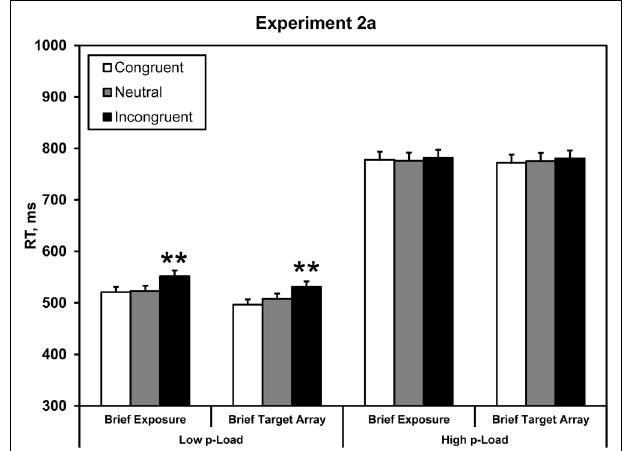
FIGURE 4 | Mean correct RT in Experiment 2a. Briefly exposed stimuli were presented for 100 ms – all other stimuli were response-terminated. Asterisks denote significance from neutral condition: ** p < 0.01. Error bars represent 95% within-observers confidence intervals (Loftus and Masson, 1994; Morey,